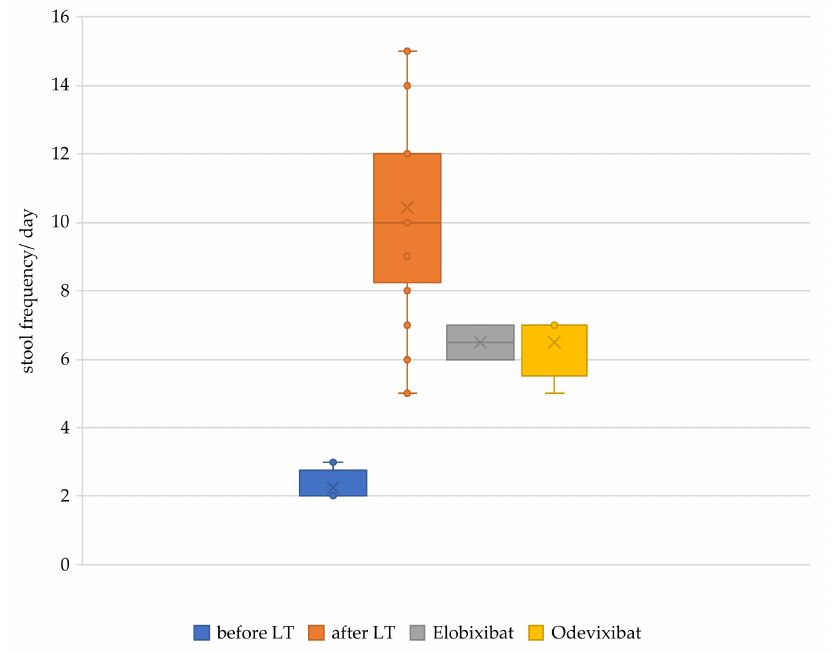
Figure 2. Daily stool frequency before liver transplantation, after liver transplantation, and with IBAT inhibitor. LT, liver transplantation; IBAT, ileal bile acid transporter inhibitor.